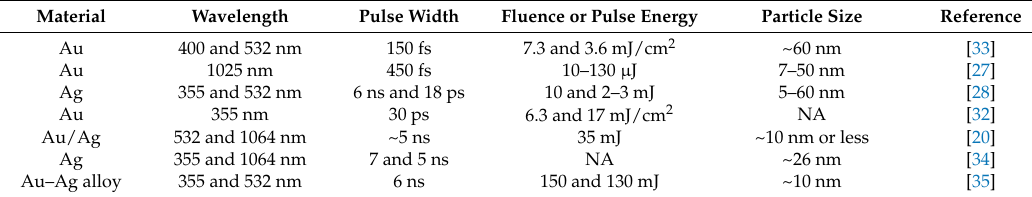
Table 1. Characteristics of the nanoparticles produced using various laser